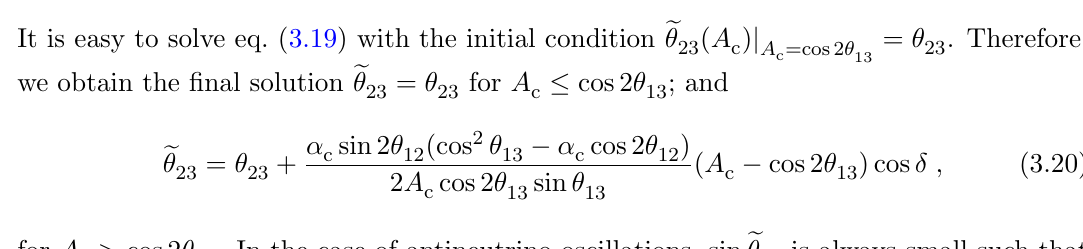
( A ) j = (cid:18) . c 23 23 A c =cos2 (cid:18) 13